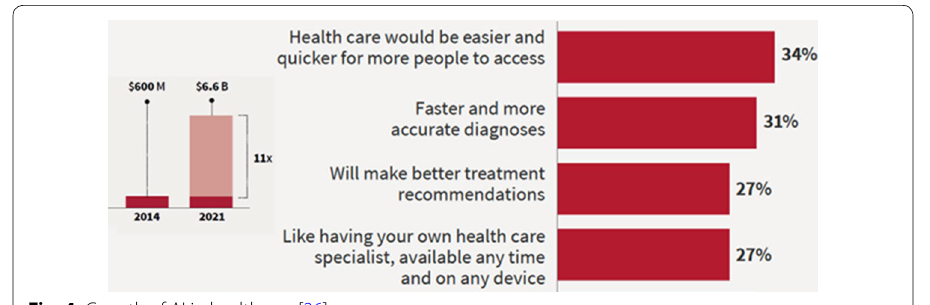
Fig. 4 Growth of AI in healthcare